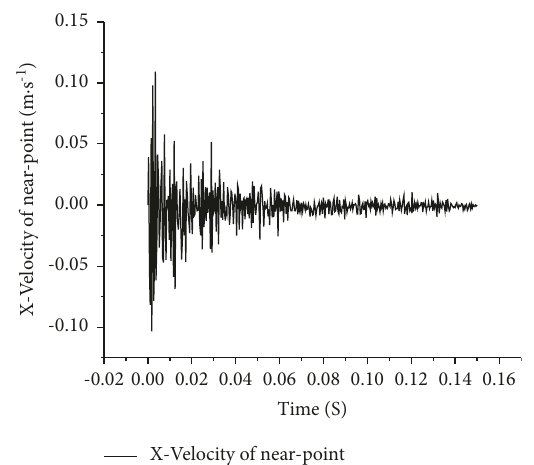
Figure 12: X-vibration time course of far-point at arch waist.